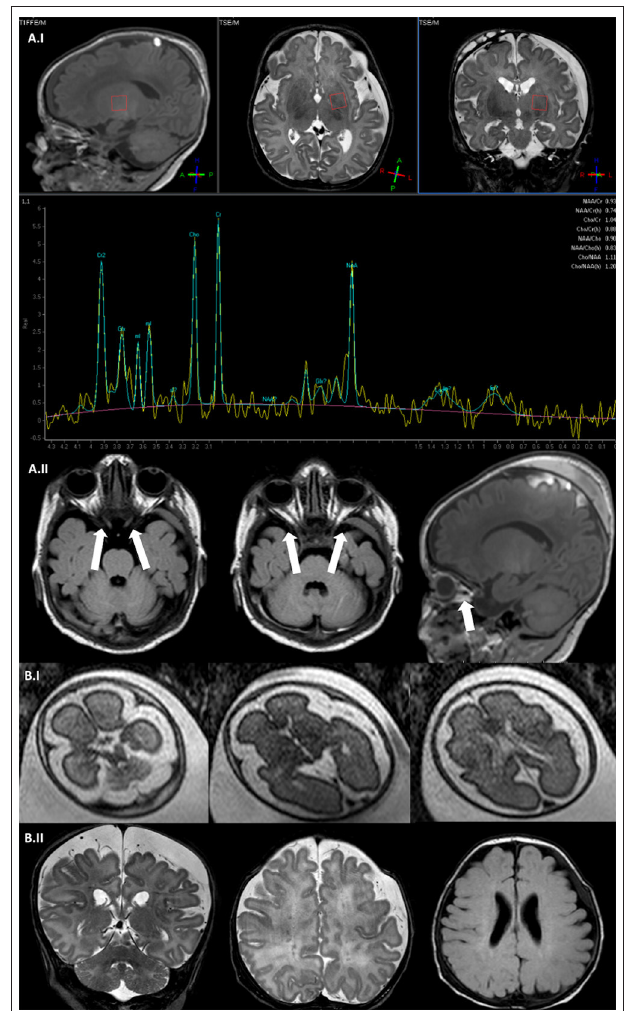
FIGURE 2 | Brain MRI. (A.I) Fetal brain MRI (Patient II; 27G.A.), axial SShTSE T2 images showing a bilateral enlargement of periencephalic spaces. (A.II) Brain MRI coronal and axial TSE T2 image (Patient II; 2 months) showing enlargement of periencephalic spaces with subdural hematoma, multiple punctate lesions correlated with prematurity in the periventricular white matter. (B.I) Spectral brain MRI with a single voxel = 35ms positioned at the left basal ganglia showing a slight increase of lactate peak (Patient I, 15 days). (B.II) Axial and coronal TSE T2 image showing a bilateral optic nerve thinning and the subdural hematoma (Patient I, 15